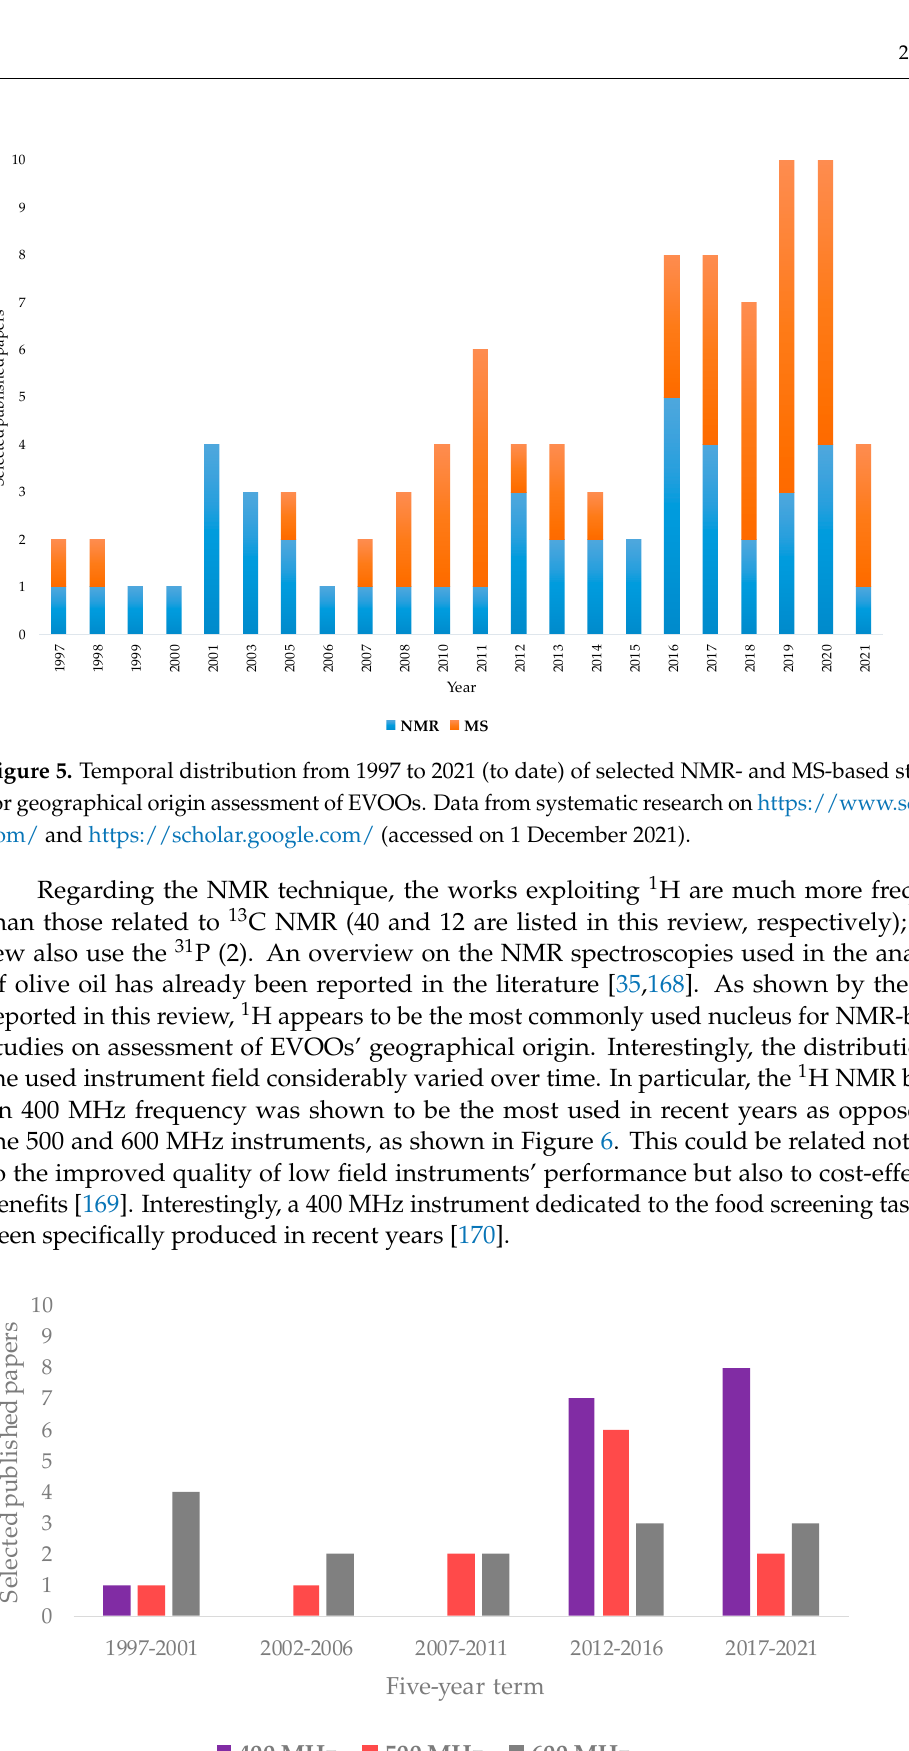
Figure 6. Evolution over five-year period of main 1 H NMR frequencies (400, 500, and 600 MHz) reported in here selected studies.